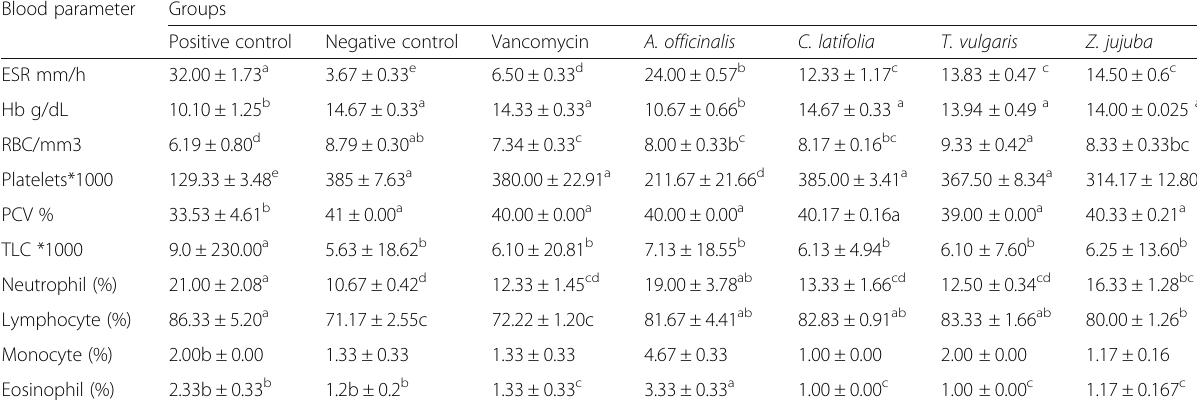
Table 6 Effect of medicinal plant treatment on hematological parameters of mice at 8th -day post infection Blood